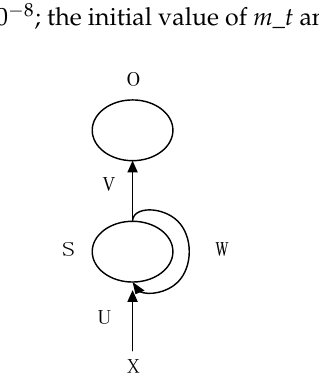
Figure 1. Recurrent neural network (RNN) structure diagram.